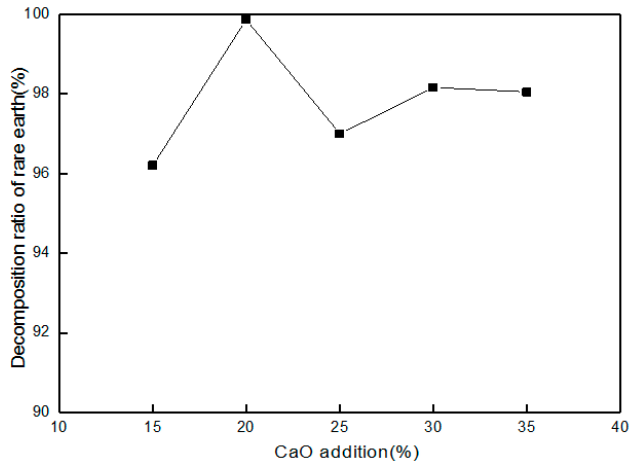
Figure 6. Effect of CaO addition on the decomposition rate of REE.